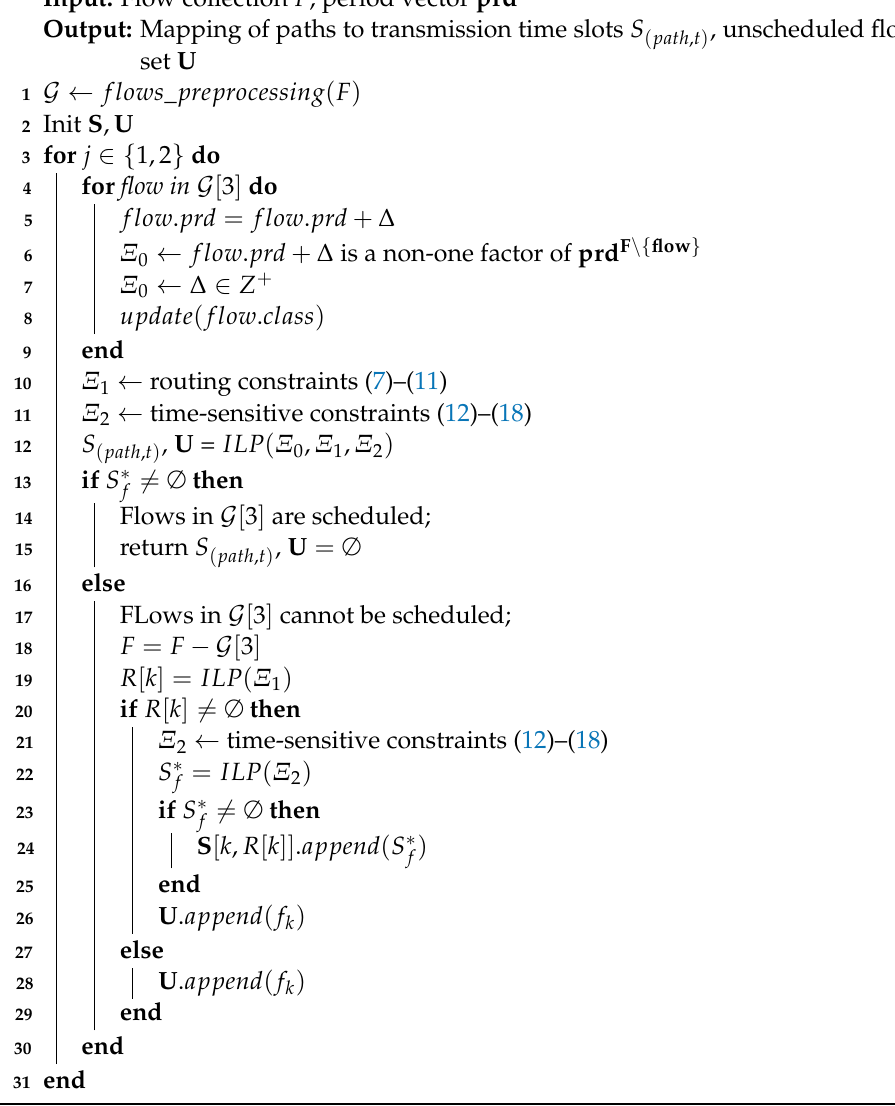
Algorithm 3: An adaptive period compensation routing and scheduling with flow